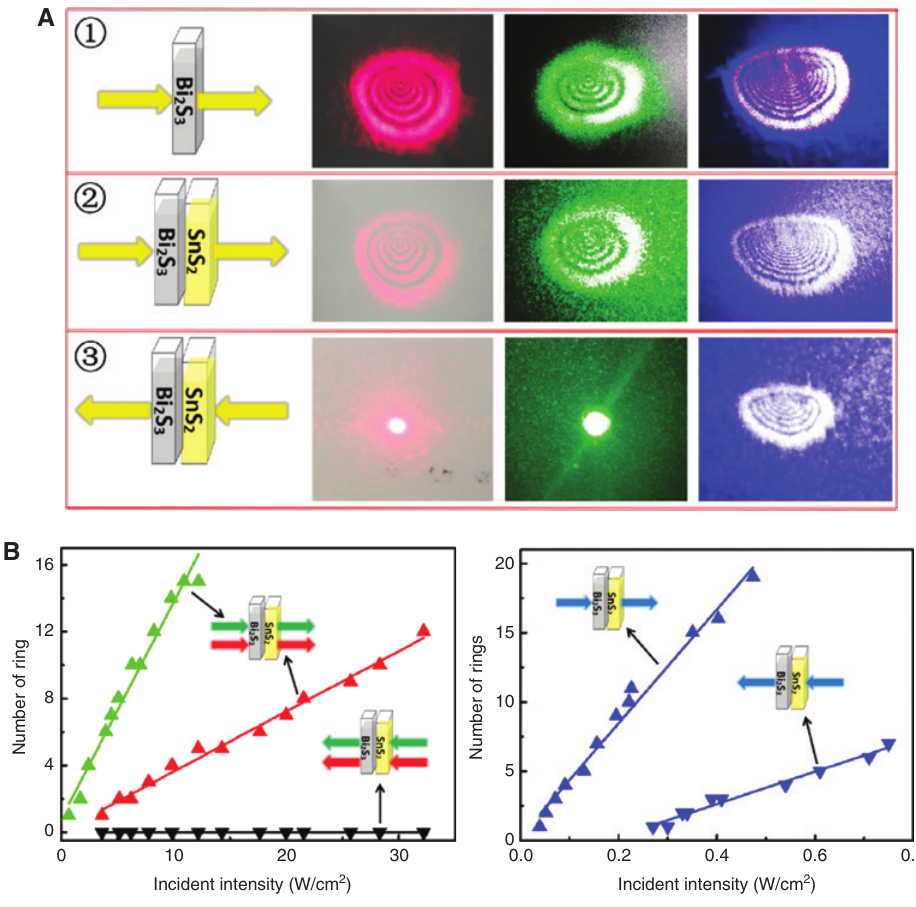
Figure 8: The experiment and data of all-optical diode. (A) Experiments of all-optical diode with a different range of wavelength; (B) the experimental data of diode with λ = 532 nm and λ = 671 nm, contrasting with λ = 457 nm based on the identical